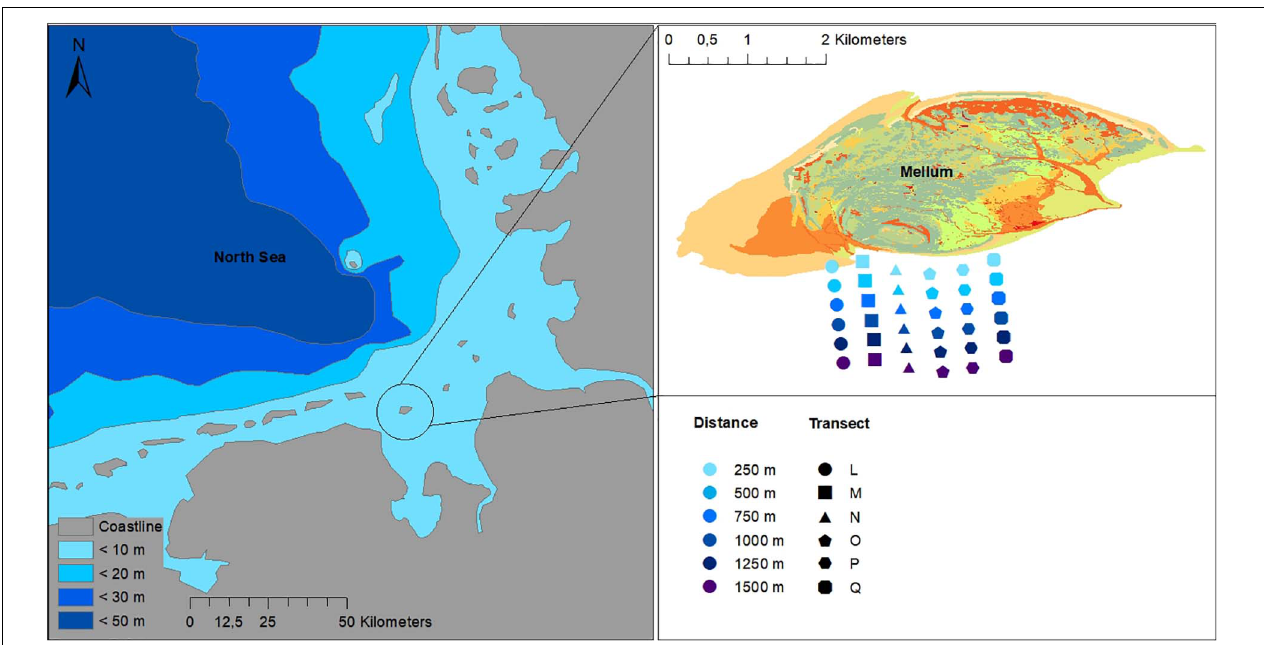
FIGURE 1 | Study area south of the island of Mellum in the German part of the Wadden Sea National Park (Lower Saxony). Sampled transects (L-Q) were sampled in 250 m steps from 250 m up to 1,500 m distance from high water line (Distance).